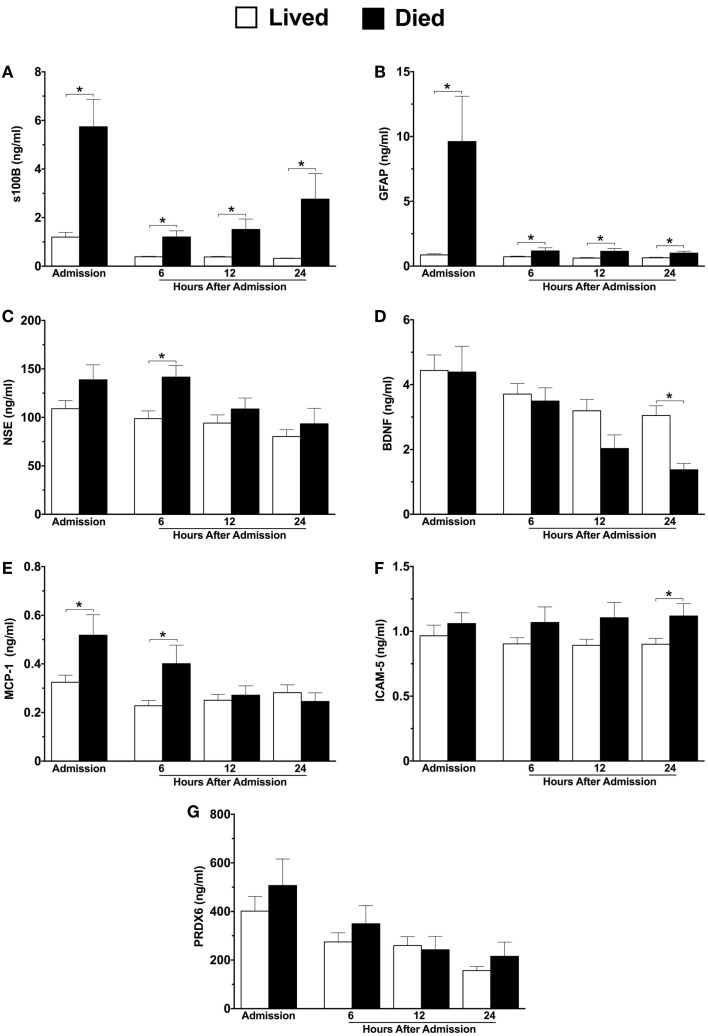
Plasma concentrations of neuroinjury biomarkers in combined moderate-to-severe TBI patients within the first 24 h of hospital admission, stratified by patients who lived versus died. Lived, n = 61; Died, n = 24. s100 calcium binding protein (A), glial fibrillary acidic protein (B), neuron specific enolase (C), brain-derived neurotrophic factor (D), monocyte chemoattractant protein-1 (E), intercellular adhesion molecule-5 (F), peroxiredoxin-6 (G). Sample sizes may vary. *p ≤ 0.05 by Student’s t-test or Mann–Whitney U, where appropriate, versus patients who survived.